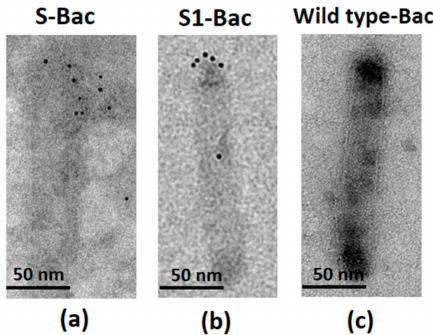
Figure 3. The detection of recombinant SBac and S1-Bac by electron microscopy (immuno-EM). The electron micrographs demonstrated positive colloid gold signals of porcine epidemic diarrhea virus (PEDV) full-length S and S1 proteins on the surface of recombinant S-Bac ( a ); S1-Bac ( b ); and wild-type Bac ( c ), respectively. S-Bac: PEDV S display baculovirus viral particle. S1-Bac: PEDV S1 display baculovirus viral particle. Wild type-Bac: wild-type baculovirus viral particle. The bars represent a reference of 50 nm.